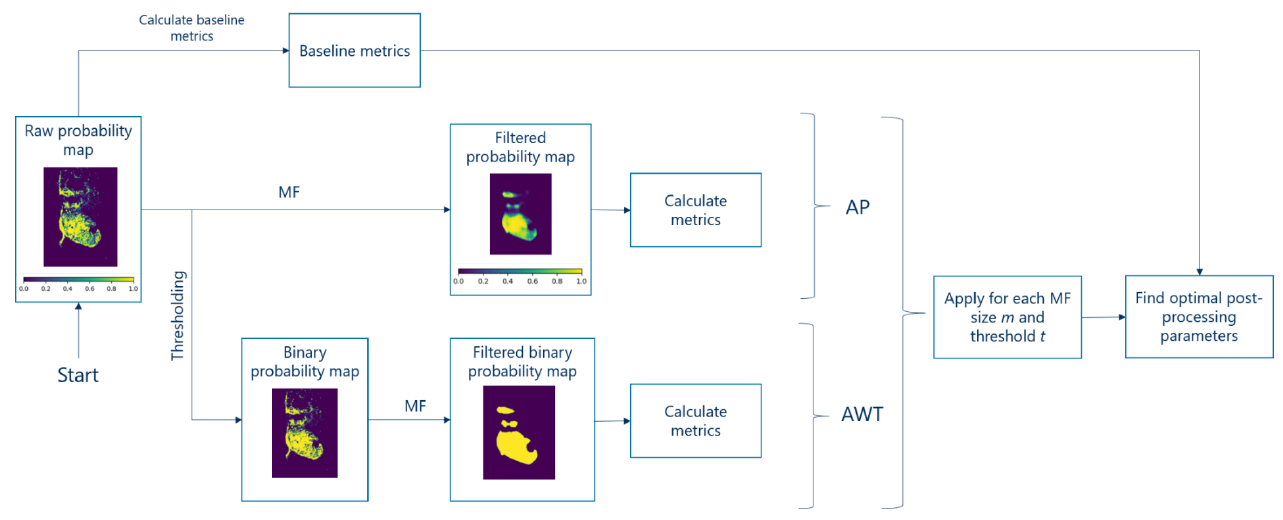
Figure 8. Pipeline with both post-processing algorithms. On the images, yellow is cancerous, purple is non-malignant. Color bars are added to the steps in which the maps contain uncertain pixels (shades of